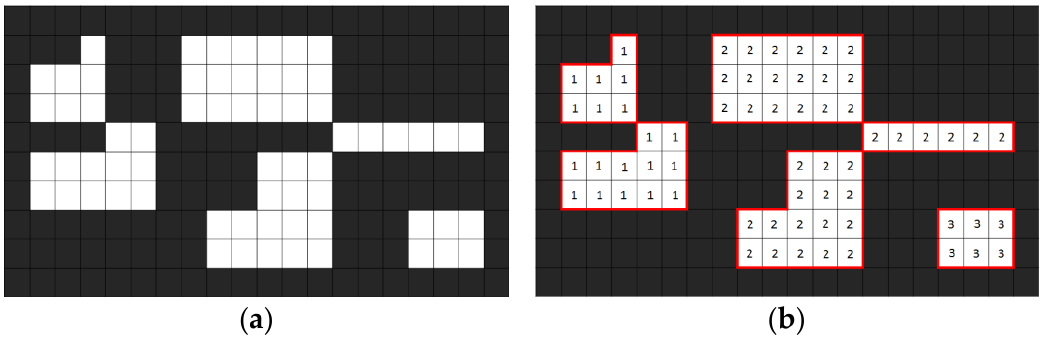
Figure 6. ( a ) Binarized image and ( b ) fabric pilling areas obtained through the 8-connected method.